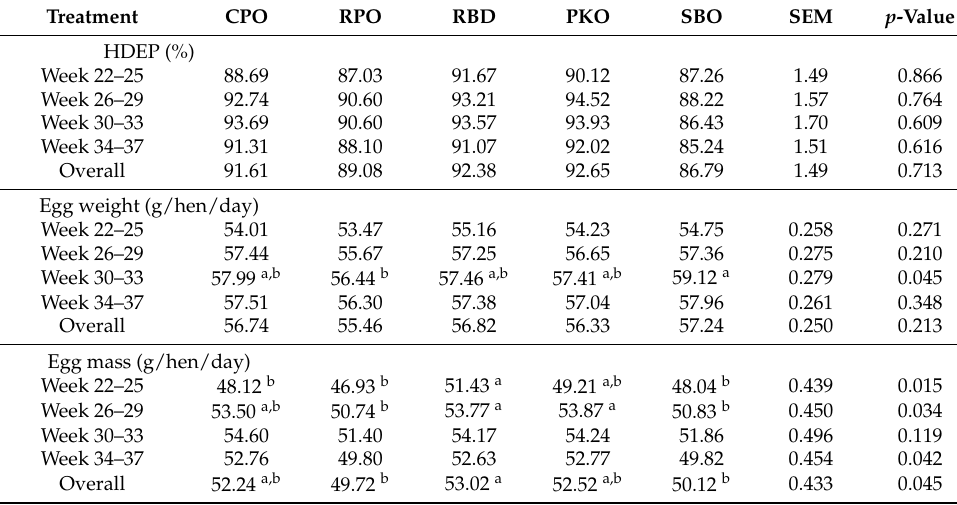
Table 3. Production performance in laying hens fed different